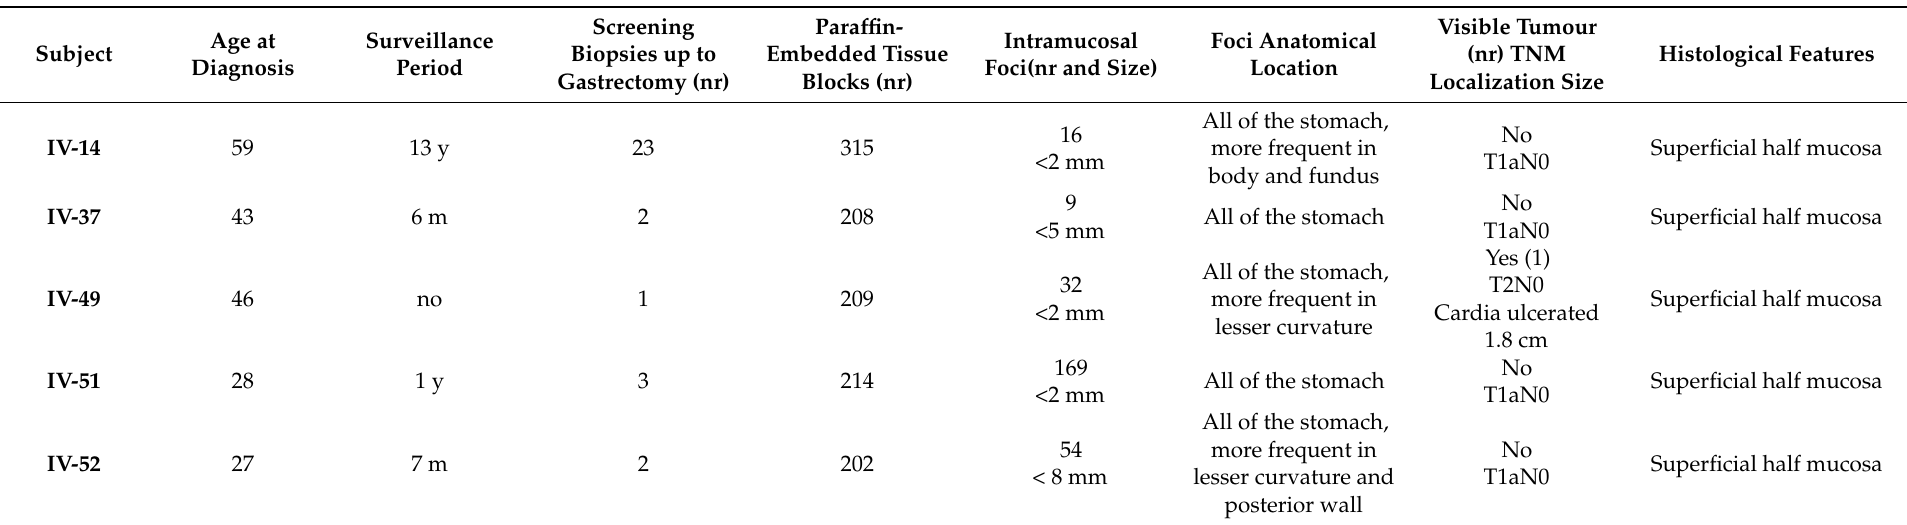
Table 1. Characteristics of patients diagnosed during follow-up endoscopic examination. For each subject, available information is provided on age at diagnosis, surveillance